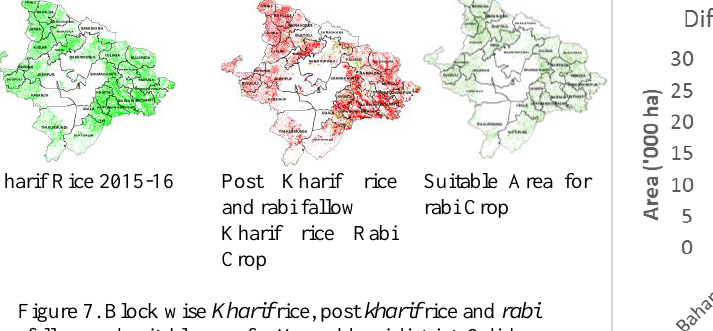
Figure 7. Block wise Kharif rice, post kharif rice and rabi fallow and suitable area for Mayurbhanj district, Odisha